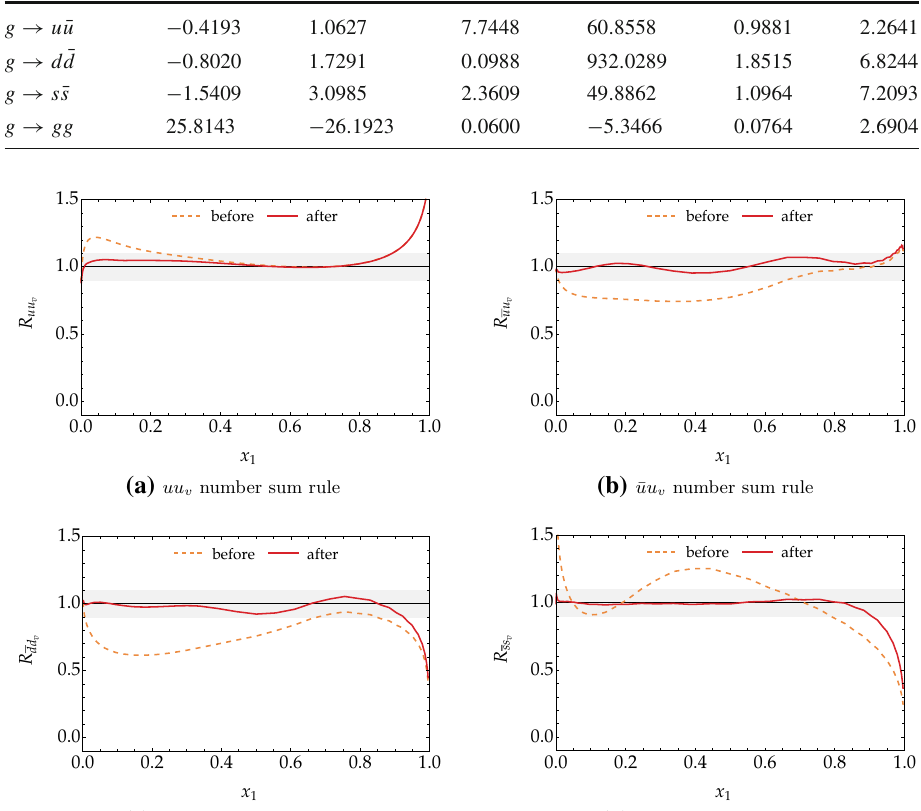
a 0 → a 1 a 2 A B 1 a 2